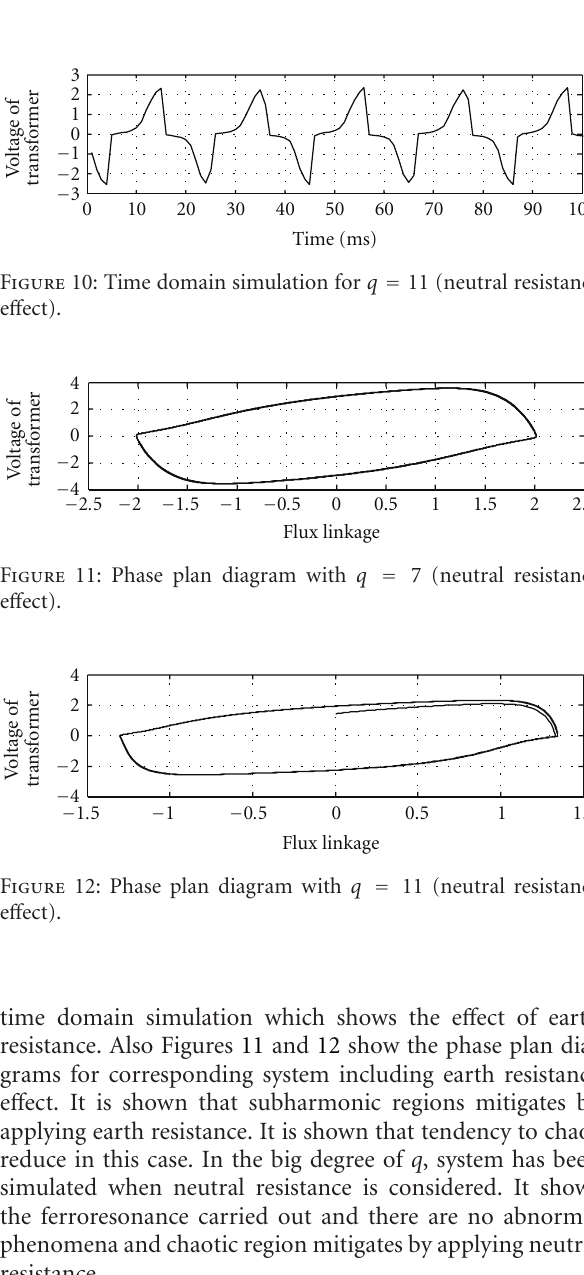
Figure 13: Bifurcation diagram with q = 7 (neutral resistance e ff ect).